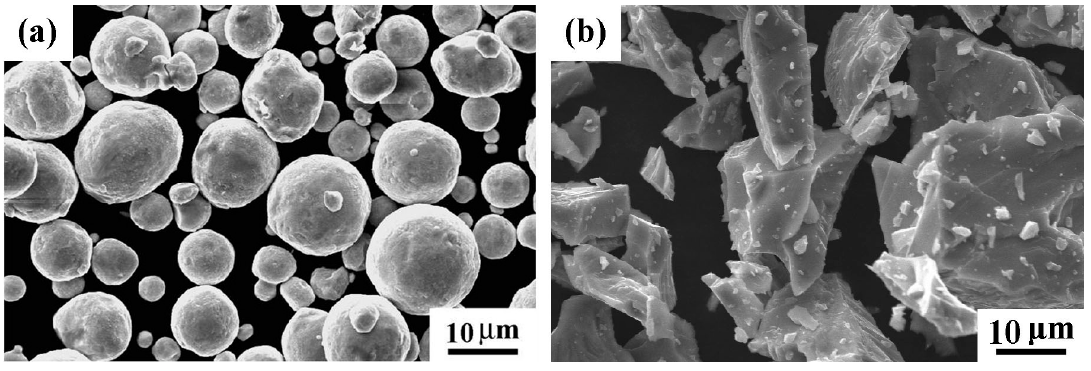
Figure 1. The microstructure of the powders: ( a ) Cu; and ( b ) TiH 2 .